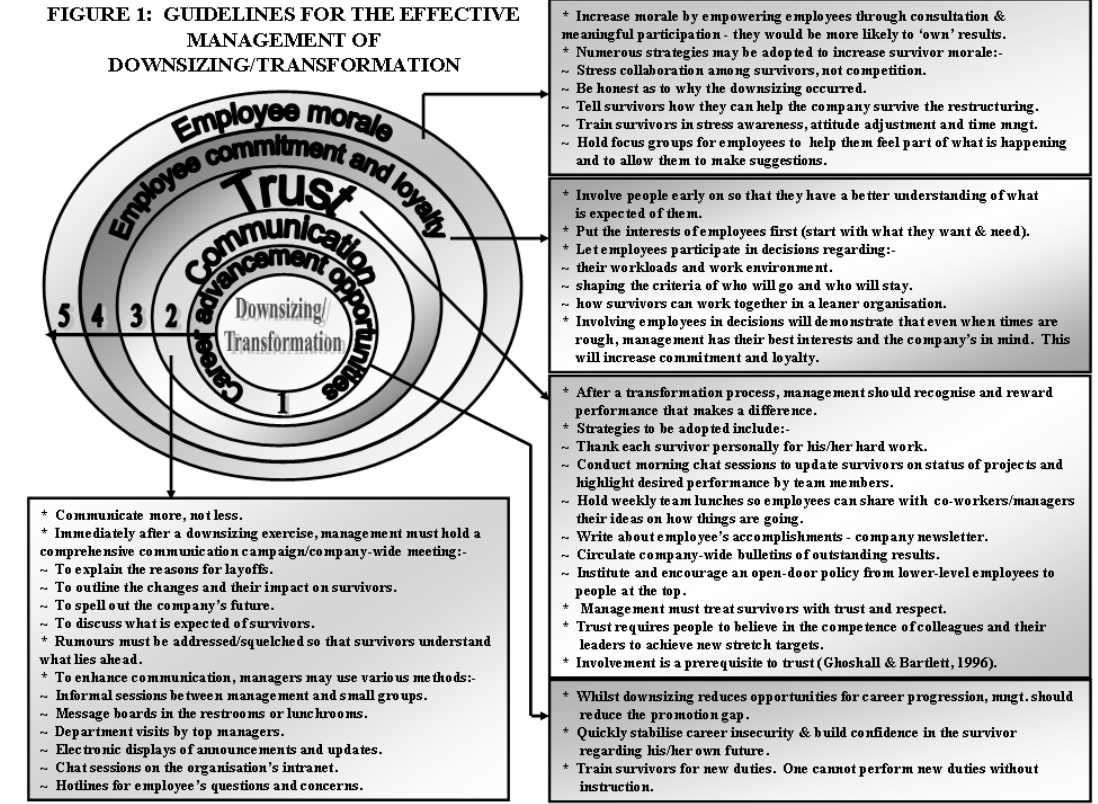
Figure 1: Guidelines for the effective management of